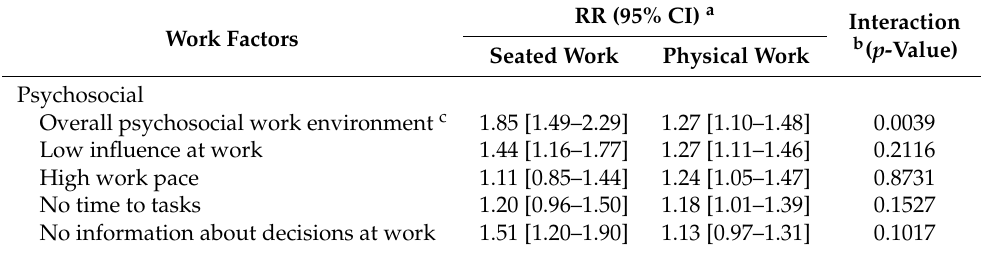
Table 3. Association between psychosocial work factors and early retirement, stratified by physical activity at work. The risk ratios (RR) represent the highest value of each scale (reference: the lowest value) (CI = confidence